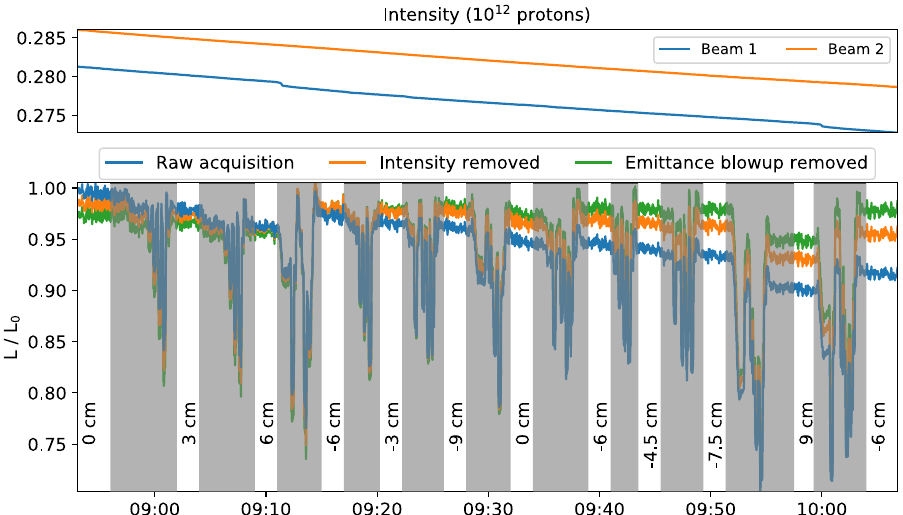
FIG. 13. Instantaneous luminosity (relative to the first raw measurement) recorded by ATLAS during the first waist scan. In blue the raw luminosity as given by ATLAS and the orange line is normalized to the beams intensity. The green line has the emittance blowup decay removed and is the one used to fit the beam waist parabola. The parts removed from the analysis are greyed out.